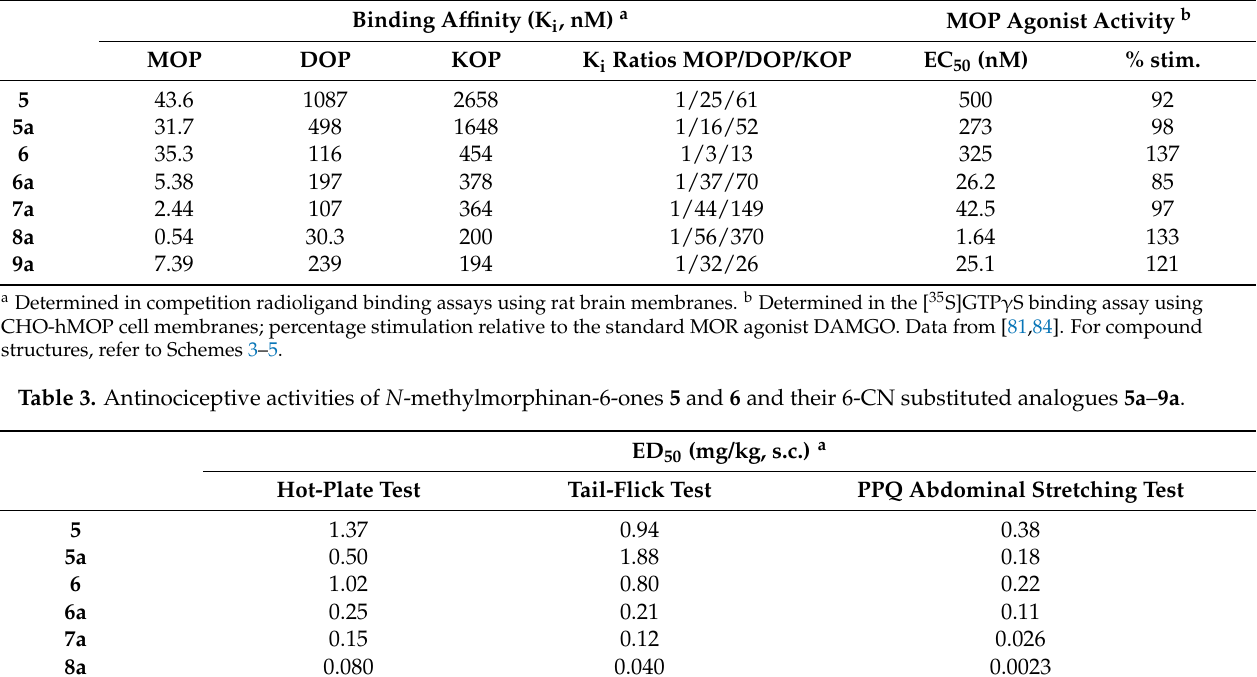
ceptor binding affinity, but also enhances the antinociceptive potency (Tables 2 and 3) [81]. Table 2. In vitro opioid activities of N -methylmorphinan-6-ones 5 and 6 , and their 6-CN substituted analogues 5a – 9a . Binding Affinity (K i , nM) a MOP Agonist Activity b KOP